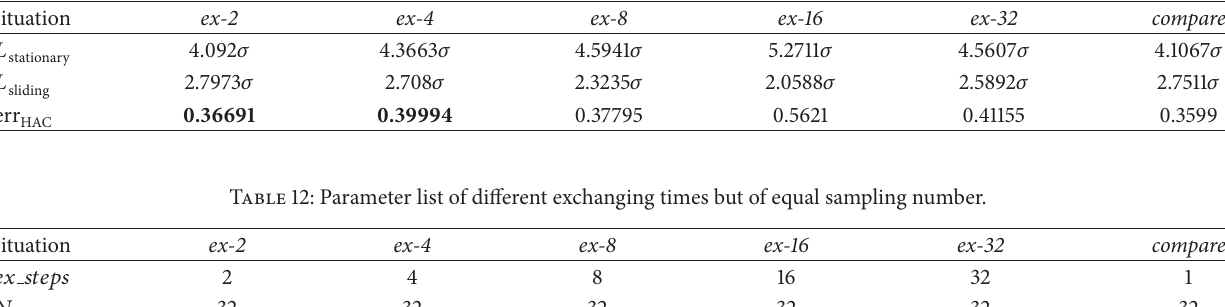
Table 11: Slip length prediction of six situations and unified relative errors with different 𝑒𝑥 𝑠𝑡𝑒𝑝𝑠 and 𝑁 .